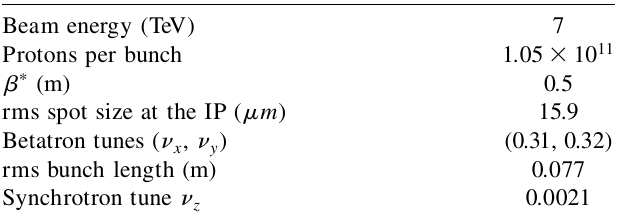
TABLE II. LHC nominal beam-beam parameters.